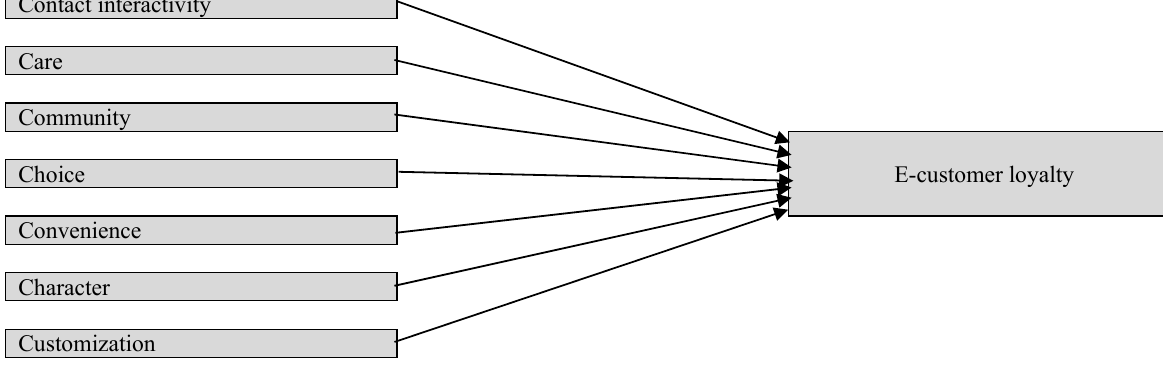
Fig.1. Research Model (adopted from Srinivasan’